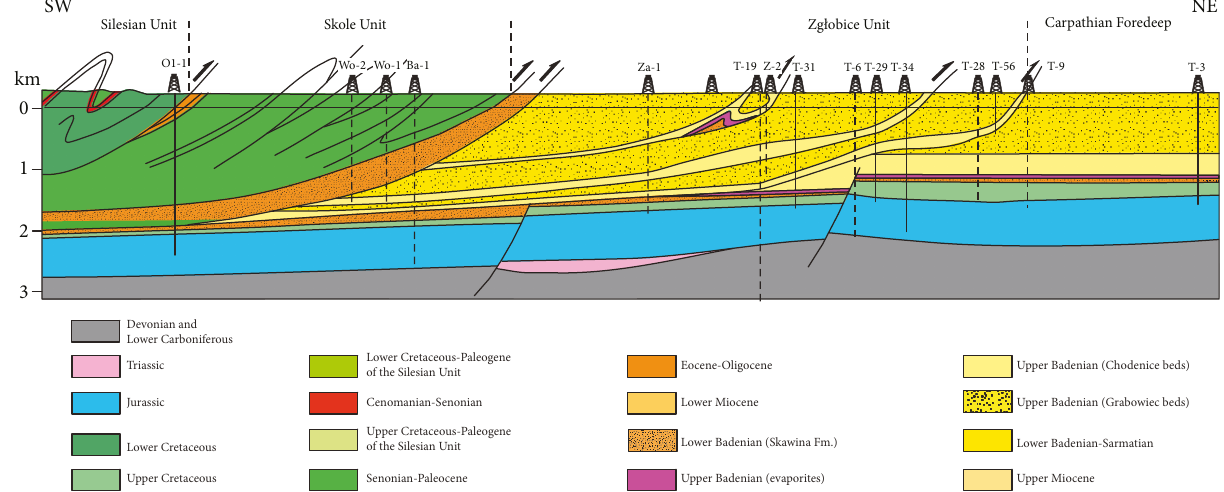
Figure 2: Geological cross section through the marginal part of the Polish Carpathians west of Tarnów (after [30], modi fi ed). Table 1: Molecular composition and hydrocarbon ratios of natural gases from autochthonous Miocene strata and Mesozoic basement. Molecular composition (vol.%) Hydrocarbon Well Depth (m) Age of reservoir